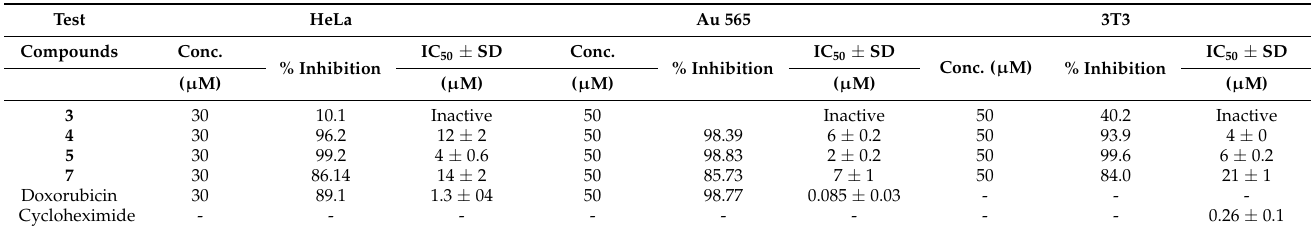
Table 2. Cytotoxicity of compounds 3 , 4 , 5 and 7 against HeLa, Au565 cancer, and 3T3 normal cell lines. Test HeLa